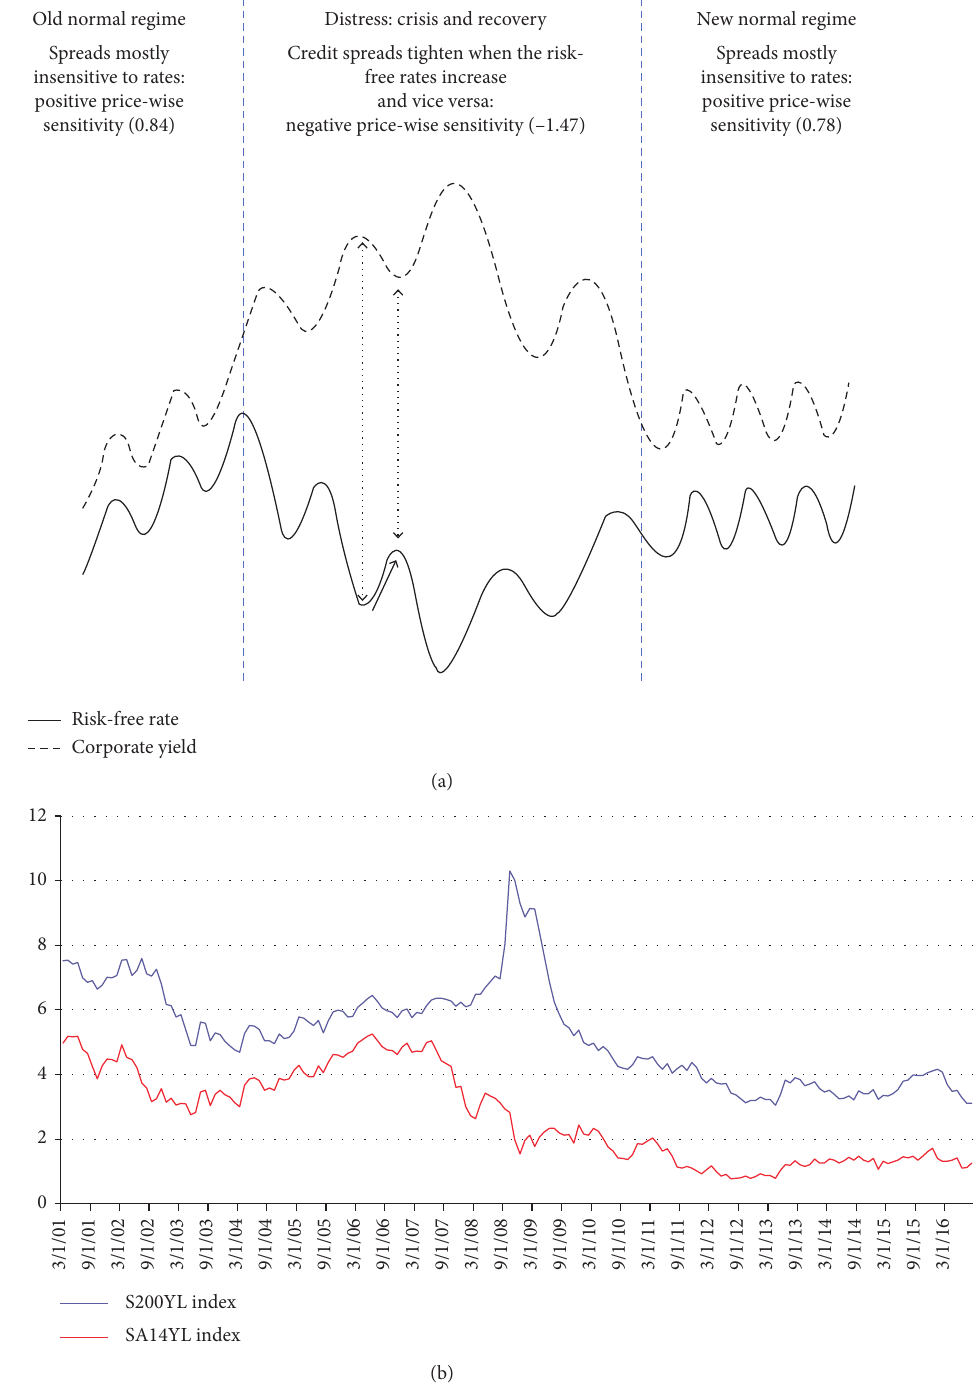
Figure 9: Spread-to-risk-free rate dynamics compared to observed yields. (a) Negative spread-to-rate sensitivity in distress compared to null sensitivity in “normal” times. (b) US BBB-rated (blue) and UST (red) bond